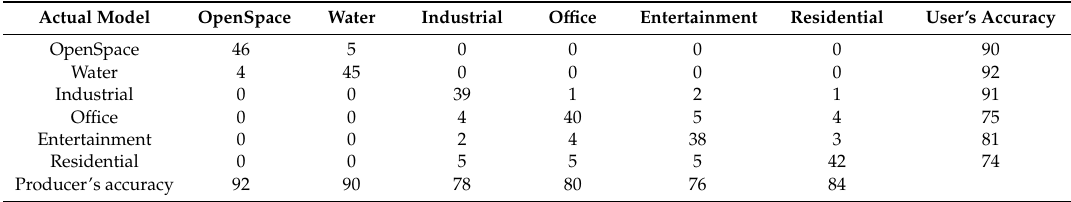
Table A3. Confusion matrix of decision tree classified map using integration of remote and social sensing (with data cleaning).